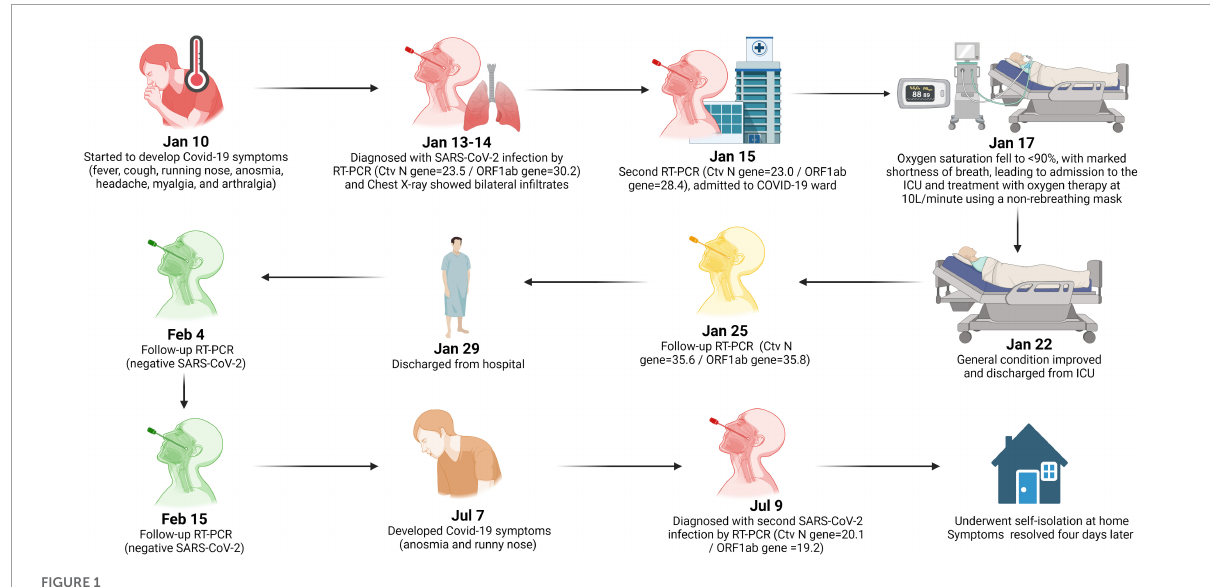
FIGURE1 Timeline of reinfection case. Image was created with BioRender.com.